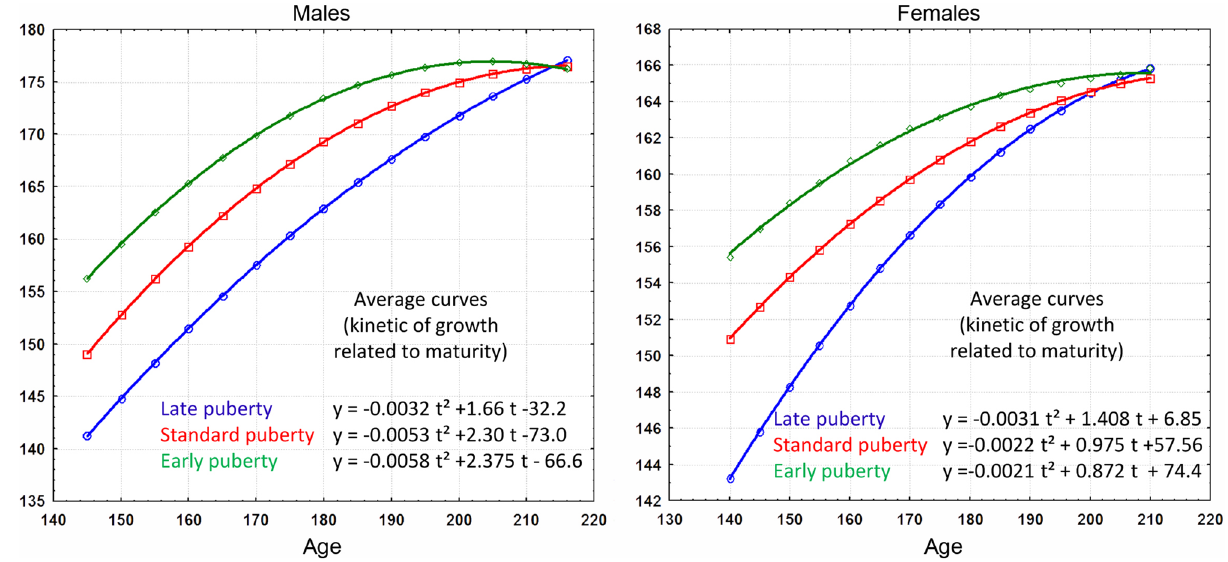
Figure 2. Polynomial curves of degree 2 in stature (y = cm) for males and females according to age (t = months). These curves were modelled over the age range of 120 to 216 months using average curves that represent growth kinetics as a function of biological maturation. In the projection, average stature values converge at around 177 cm at the age of 216 months (18 years) for males and around 165 cm at the age of 17.5 years for females. The standard deviation for stature is 6 cm in males and 5.6 cm in